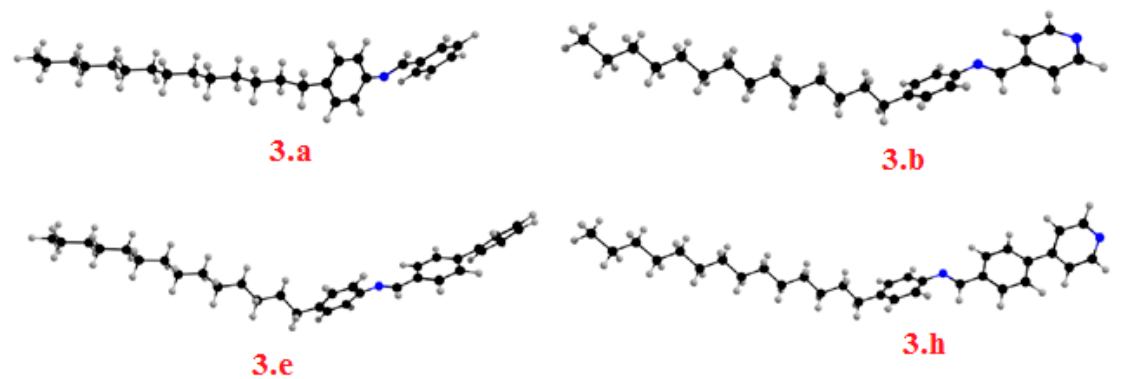
Figure 4. Optimized geometrical structure of the prepared compounds 3.a , 3.b , 3.e and 3.h .